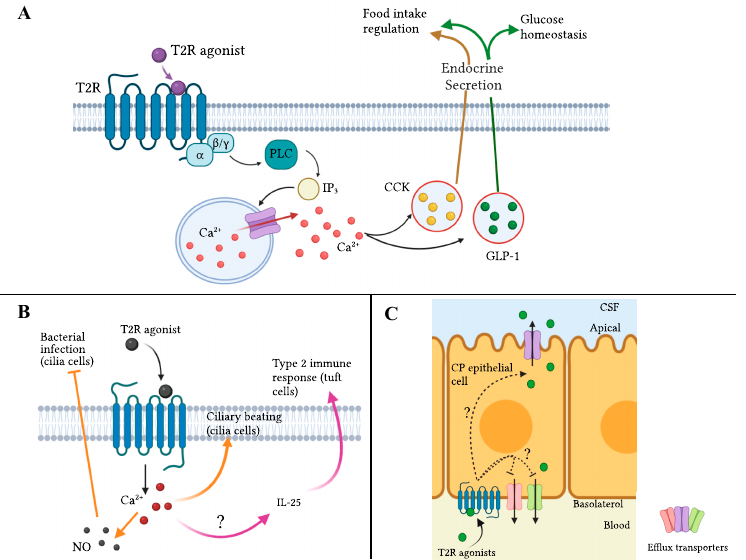
Figure 3. Proposed model of T2R signaling pathways impacting physiological health. ( A ) Glucose metabolism and obesity: in enteroendocrine cells, T2R agonists activate T2Rs to cause increased calcium release from calcium channels on the endoplasmic reticulum, leading to GLP-1 and/or CCK secretion. ( B ) Innate immunity: in cilia cells, the activation of T2Rs by T2R agonists induce calcium flux, leading to increased ciliary beating and/or production of NO; in tuft cells, activation of T2Rs causes a type 2 immune response by inducing secretion of IL-25. ( C ) Neuroprotection: in human CP epithelial cells, T2Rs regulate efflux transporters at the BCSFB may facilitate transportation of neuroprotective molecules, shown to date for resveratrol [78]. Abbreviations: T2R, bitter taste receptor; GLP-1, glucagon-like peptide-1; CCK, cholecystokinin; NO, nitric oxide; CSF, cerebrospinal fluid; CP, choroid plexus; BCSFB, blood–cerebrospinal fluid barrier. Figure 3 A,B based on [70,72]. Figures created with BioRender.com.